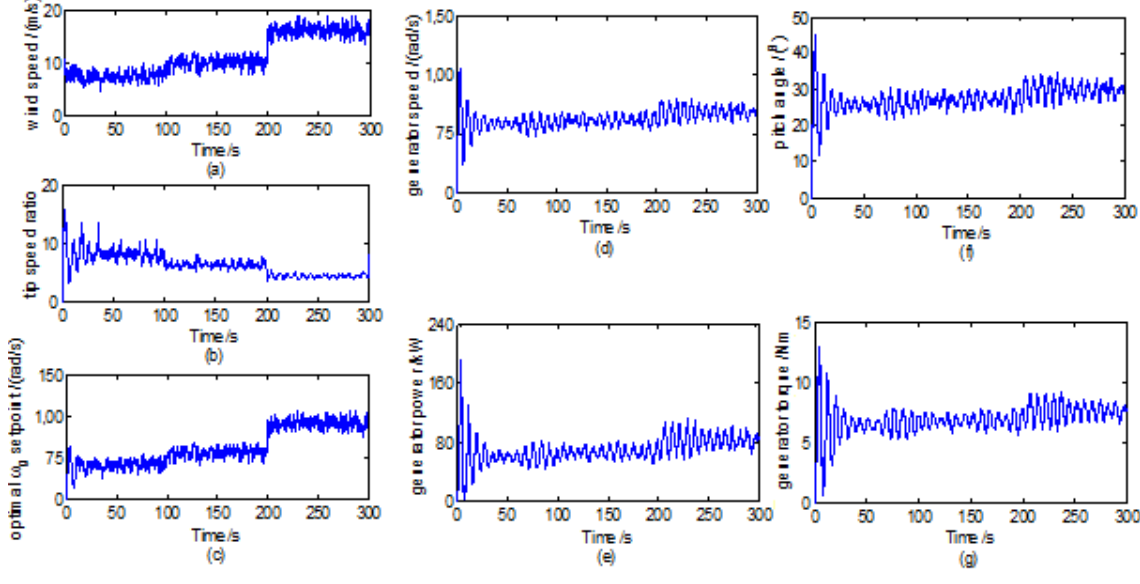
Figure 6. Actuators fault of WECS without fault tolerant control: ( a ) wind speed (m/s); ( b ) the tip speed ratio; ( c ) optimal (cid:2033) setpiont (rad/s); ( d ) generator speed (rad/s); ( e ) generator (cid:3034) power (KW); ( f ) the pitch angle (°); ( g ) the generator torque (Nm).